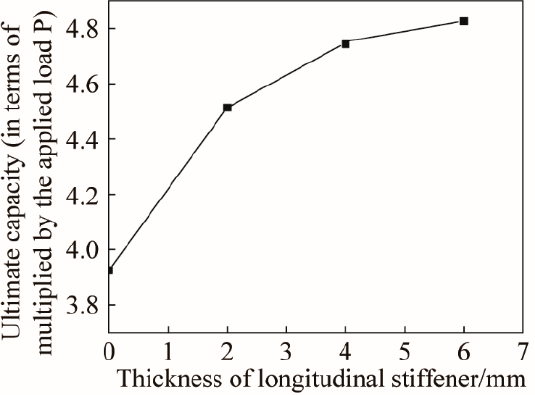
Figure 14. Relationship between the ultimate capacity and the thickness of the longitudinal stiffening rib.